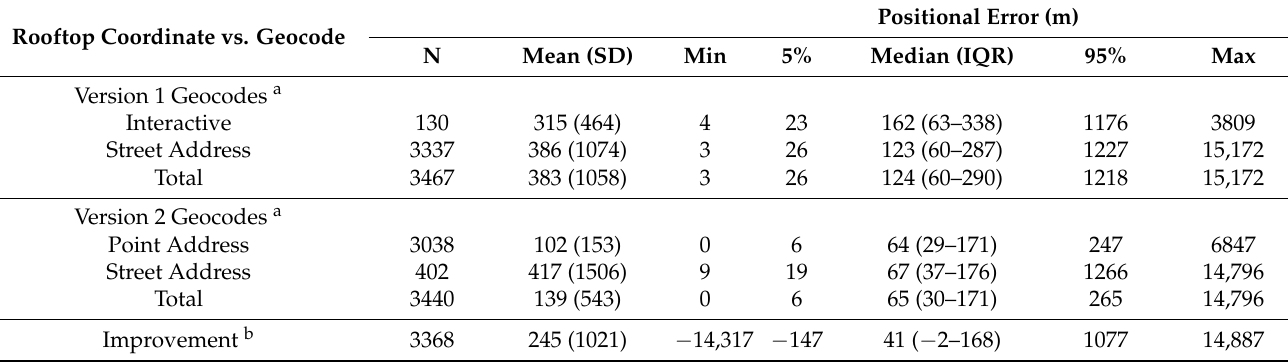
Table 3. Positional error (m) of and improvement between Version 1 and Version 2 geocodes compared to rooftop coordinates for Iowa participants by match